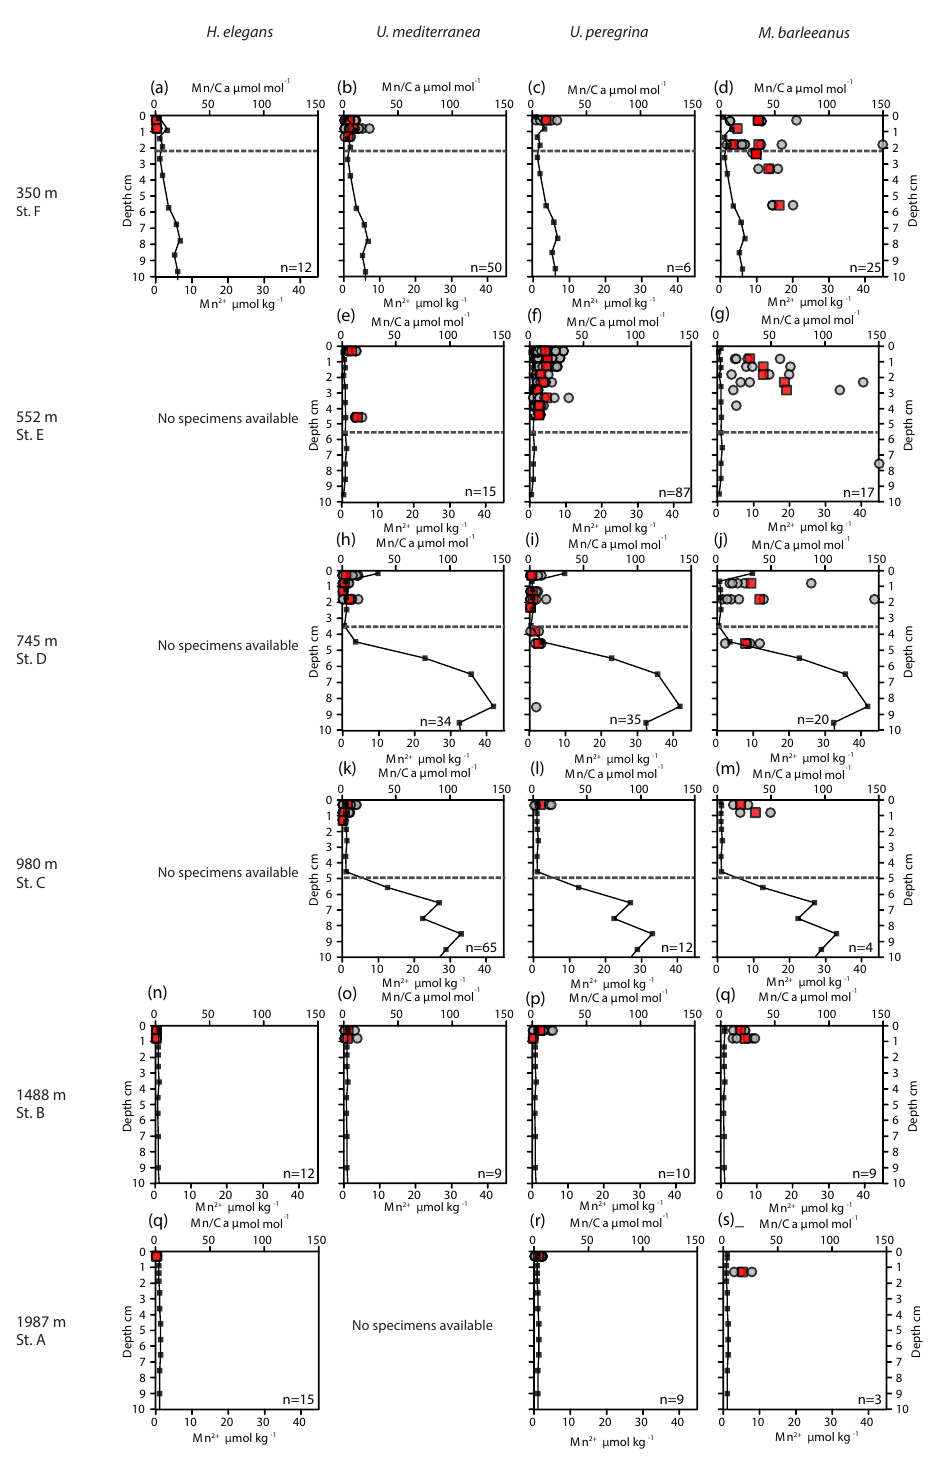
Figure 3. Plots of Mn / Ca (µmolmol − 1 ) measured in living (stained) Hoeglundina elegans , Uvigerina mediterranea , Uvigerina peregrina , and Melonis barleeanus . Individual analyses are plotted (grey circles) alongside average values for a given depth in the sediment (red squares). Pore water Mn 2 + (µmolkg − 1 ) profiles (black line) are plotted for all stations. The dashed grey line indicates the oxygen penetration depth